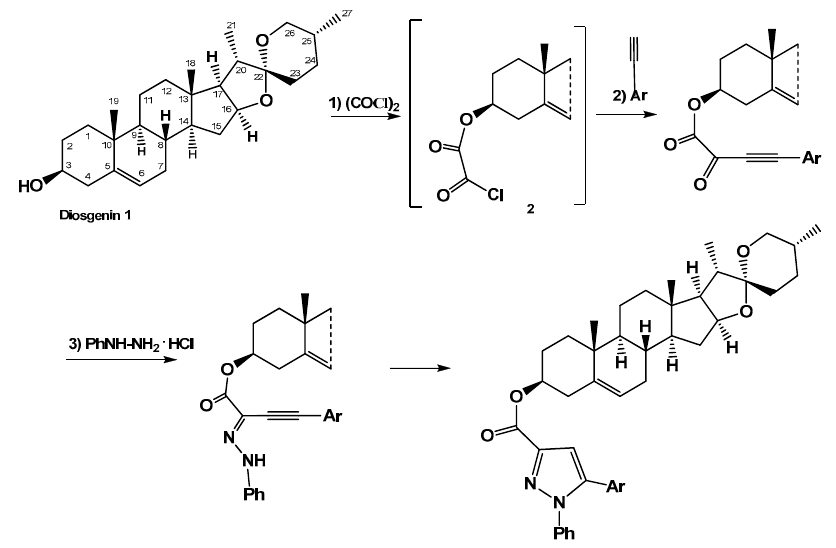
Scheme 1. Overall design strategy of 3- O -(pyrazol-3-yloxo)diosgenin